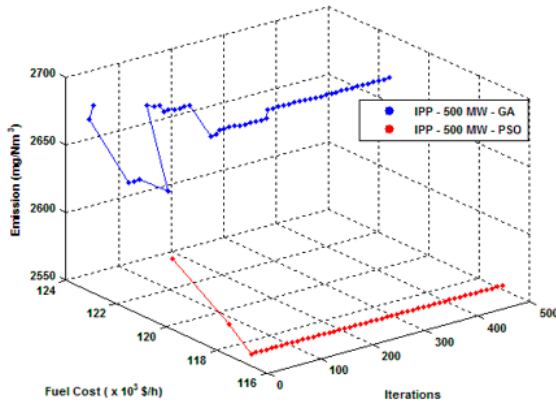
Figure 6. The convergence characteristics of PSO and GA with regard to fuel cost and emission for Pakistani IPP with P D = 500 MW.